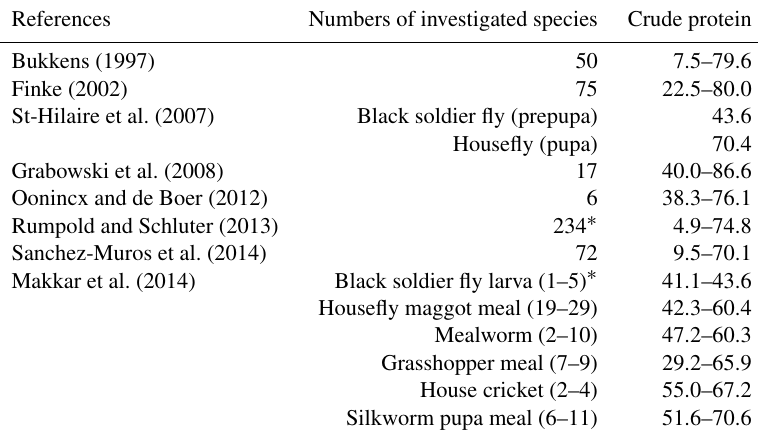
Table 17. Examples for the variation in protein content of various insect species (% of dry matter; summarized by EFSA, 2015; Flachowsky and Klüß,